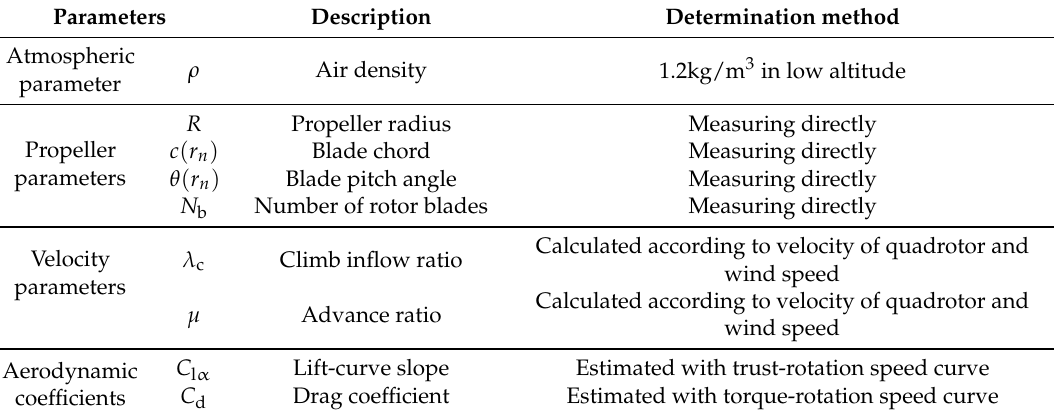
Table 1. Parameters used in the aerodynamic model of